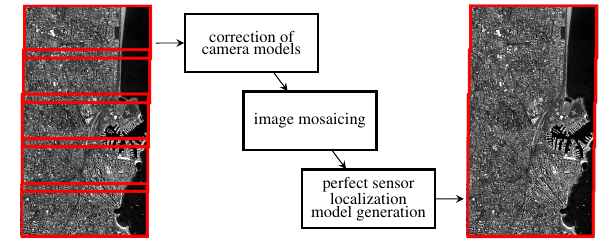
Figure 2. Diagram of the presented